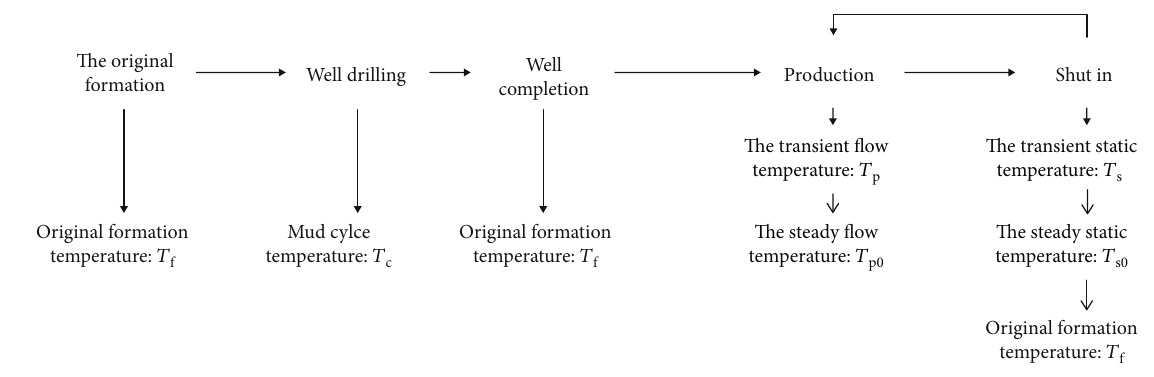
Figure 3: Well development stages and corresponding temperatures.